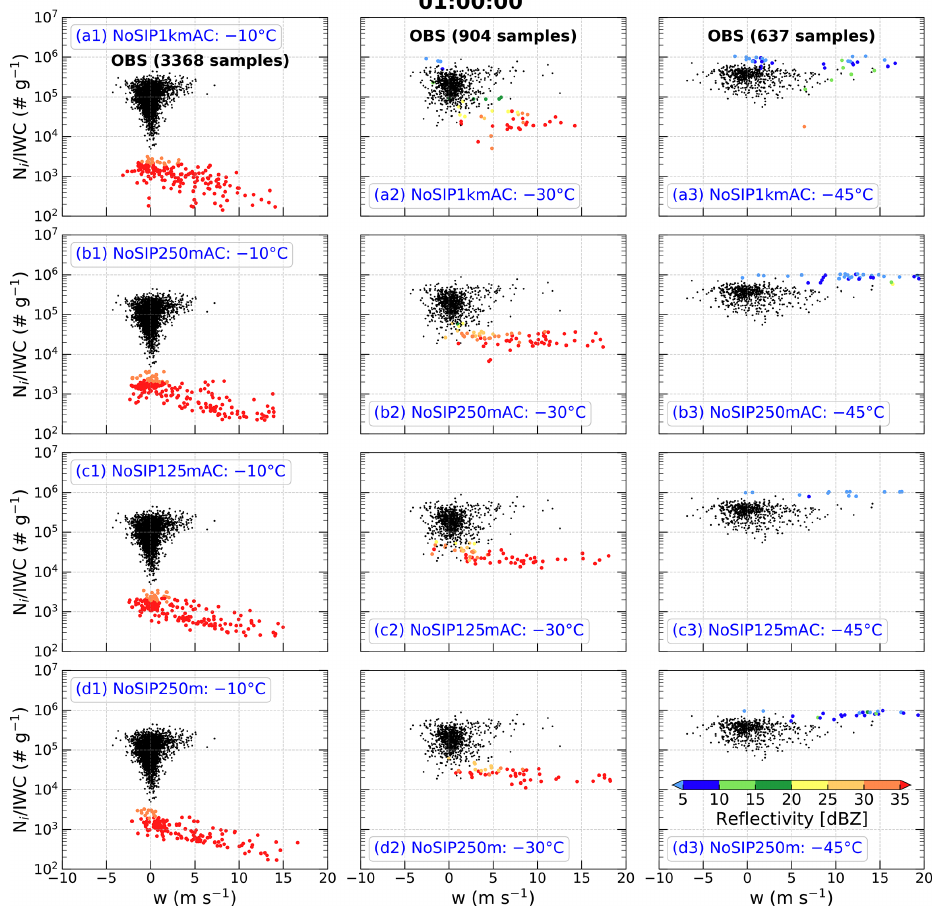
Figure A1. As in Fig. 4 but overlaid with observations in Fig. 3.